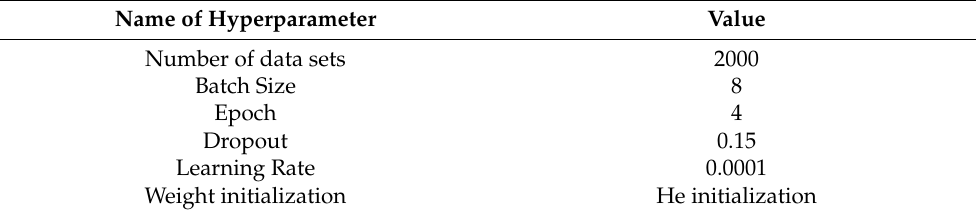
Table 3. The results of each hyperparameter assignment.